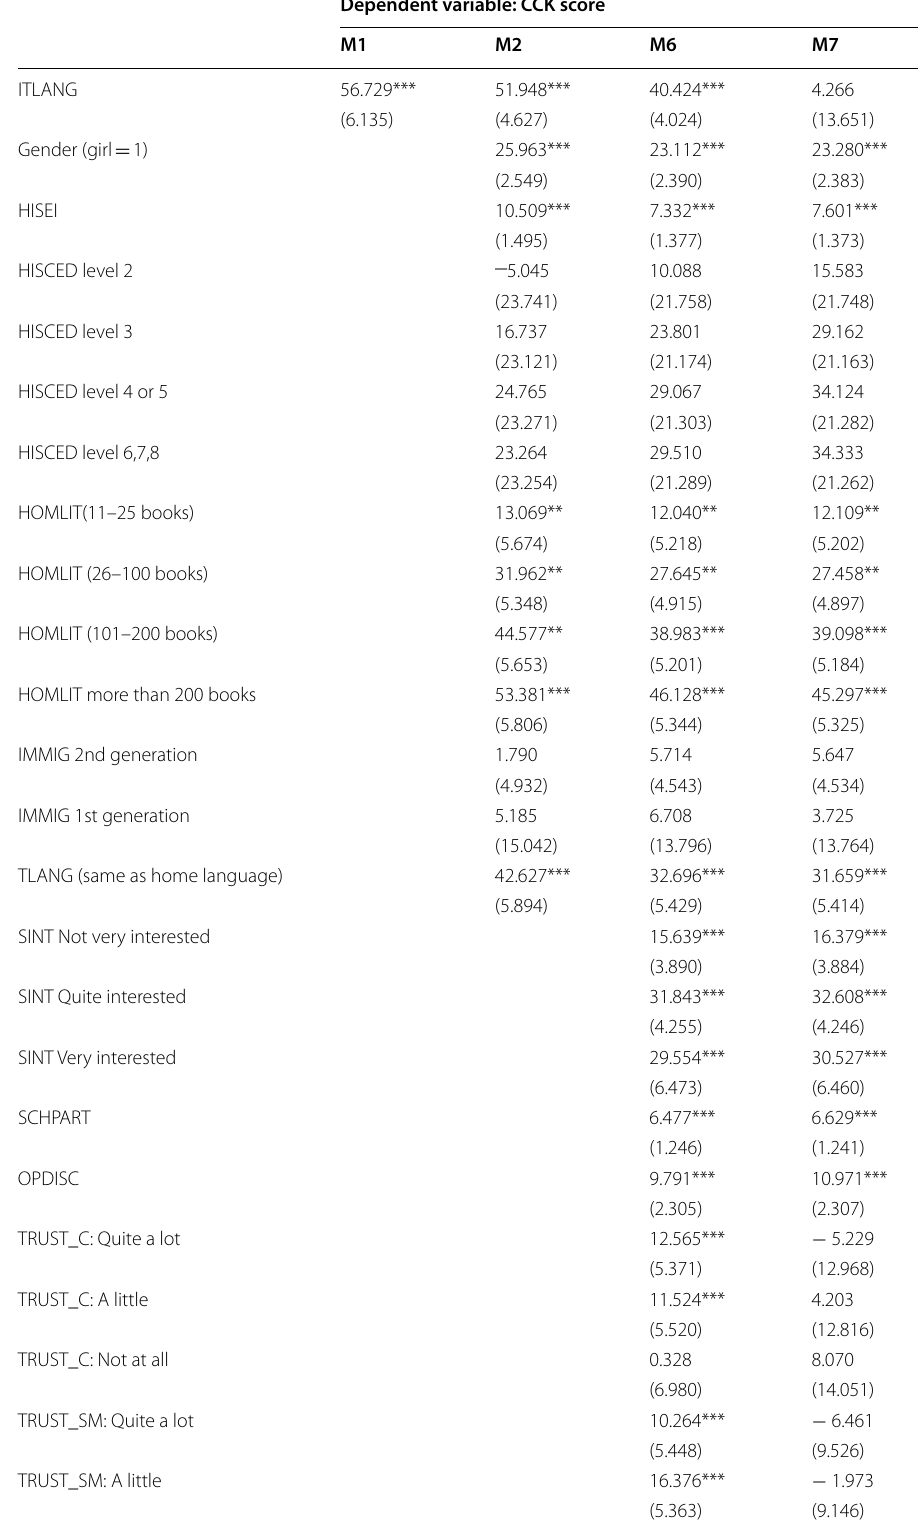
Table 8 Coefficient of the estimates of the selected models Dependent variable: CCK